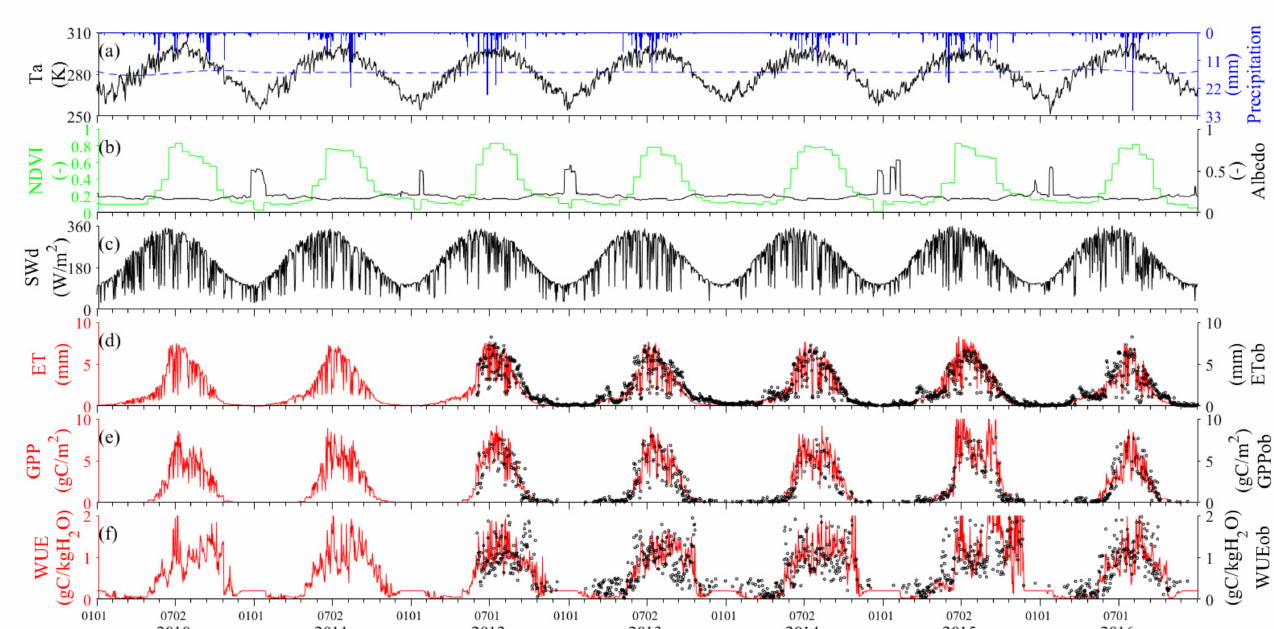
Figure 4. Comparison of estimated daily ET, GPP, and WUE with ground measurement data and response of temporal variations in daily temperature (Ta), daily precipitation, daily incident shortwave radiation (SWd), daily albedo, and normalized differential vegetation index (NDVI) (16 days) from Daman superstation in midstream oasis area of HRB from 2010 to 2016. Black circles indicate measurements from EC at Daman